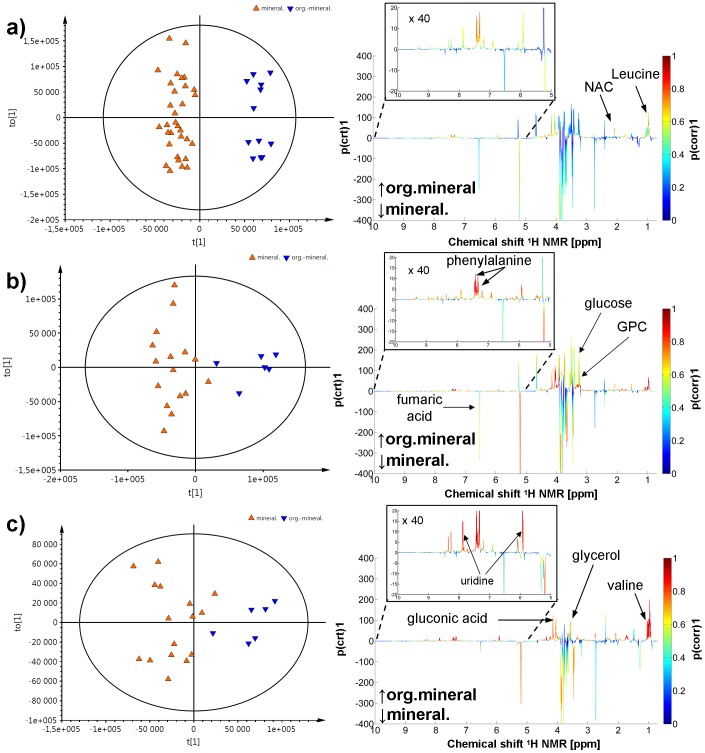
OPLS-DA score plots discriminating between samples from mineral and organic-mineral topsoil for: a) whole fruiting bodies (R
2
X = 0.924, R
2
Y = 0.944 and Q
2
Y = 0.790); b) stems (R
2
X = 0.814, R
2
Y  = 0.830, Q
2
Y = 0.728); and c) caps (R
2
X = 0.608 R
2
Y = 0.732, Q
2
Y = 0.554).The corresponding loadings from the OPLS-DA models are shown on the right. The color bar corresponds to the absolute value of the correlation loading.